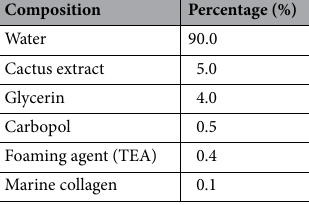
Table 1. Composition of formulation.